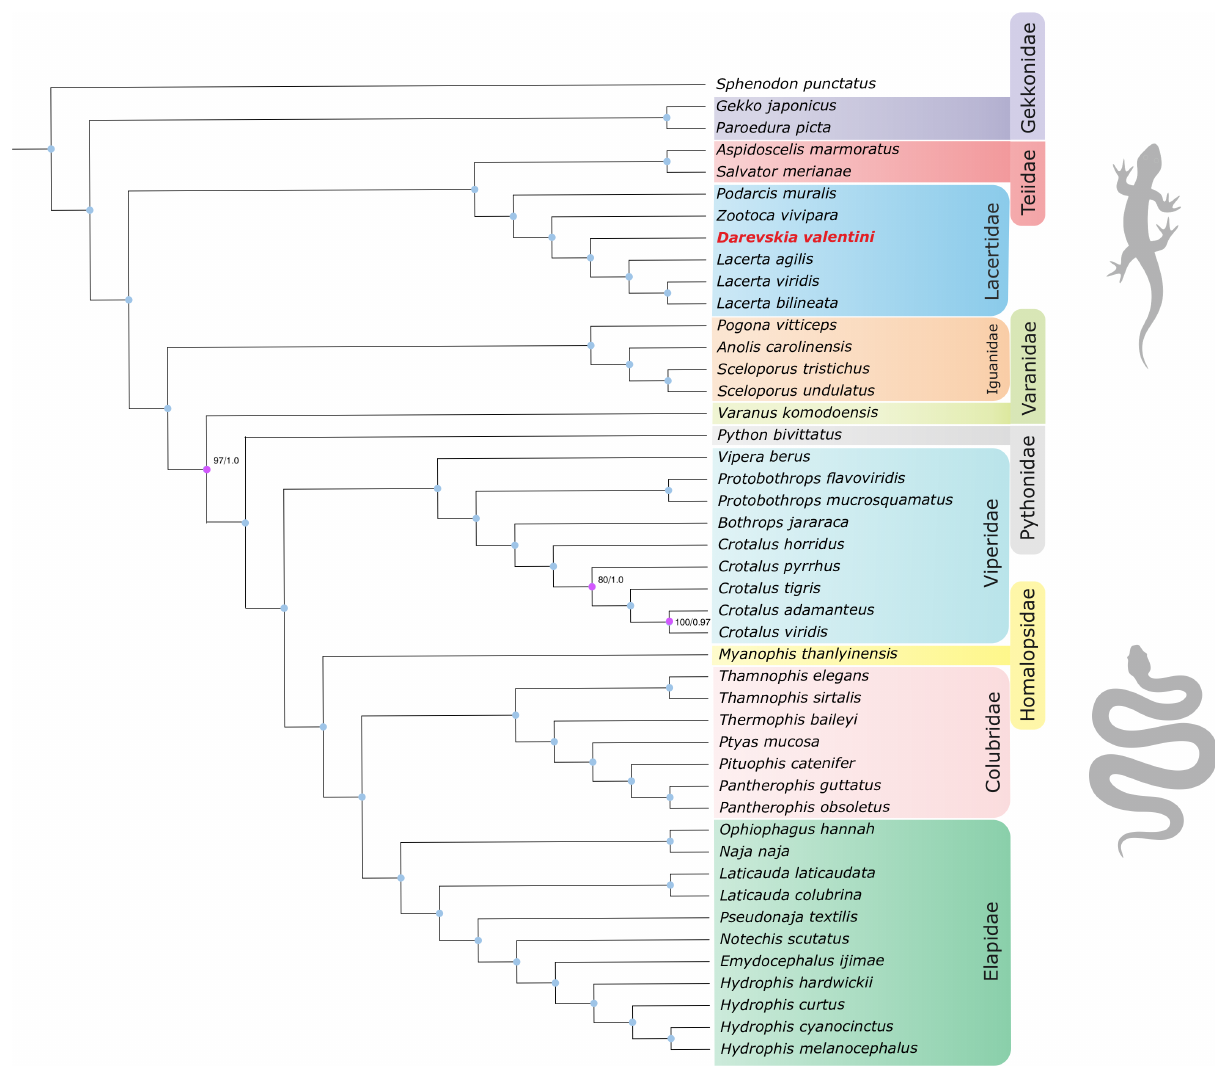
Figure 4. Coalescent species tree of lacertid lizards inferred from 7369 BUSCO maximum likelihood phylogenies. Branch support values were measured as bootstrap support (concatenation approach) and local posterior probabilities (coalescent tree approach). If not stated, the value is equal to 100/1.0 (bootstrap/posterior